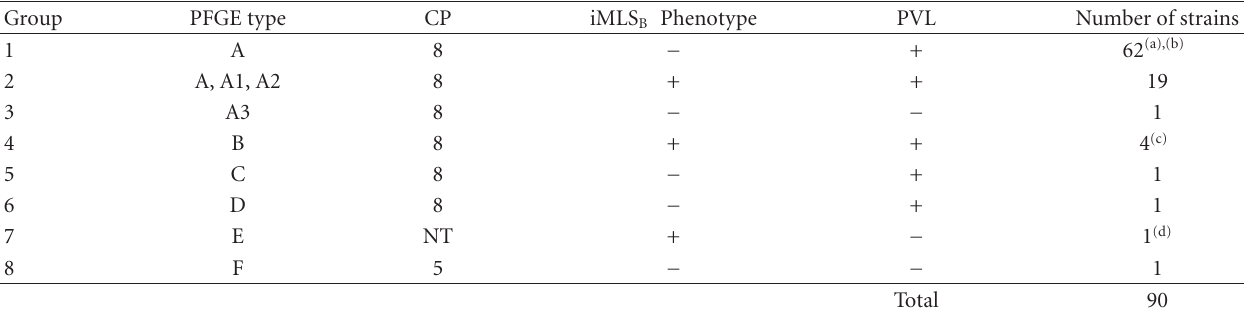
Table 1: Phenotypic and genotypic characteristics of CA-MRSA isolates recovered in Uruguay between 2004-2005. CP, capsular polysaccharide; iML B , inducible macrolide-lincosamide-streptogramin B resistance; PVL, Panton-Valentine leukocidin.